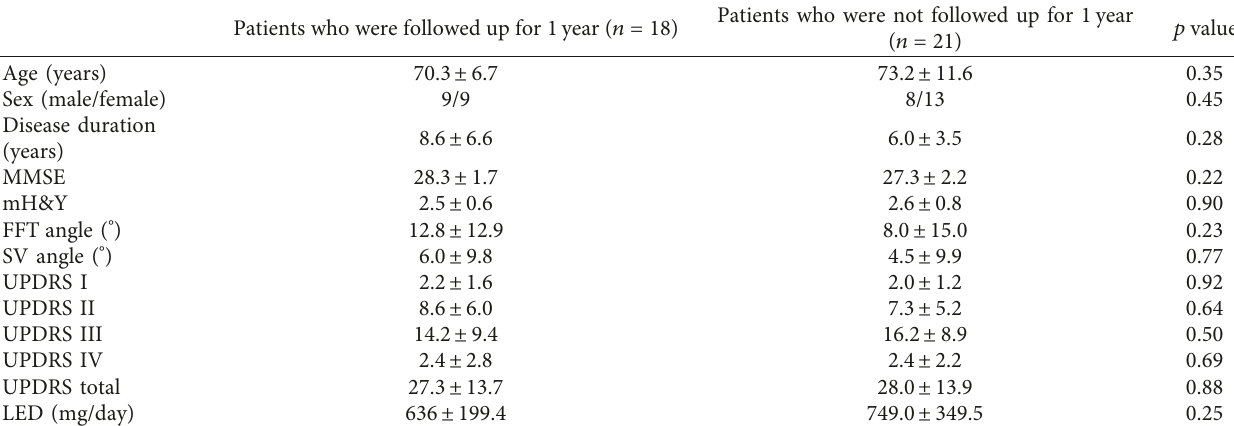
Table 2: Baseline characteristics of patients who underwent 1year of follow-up and those who did not.